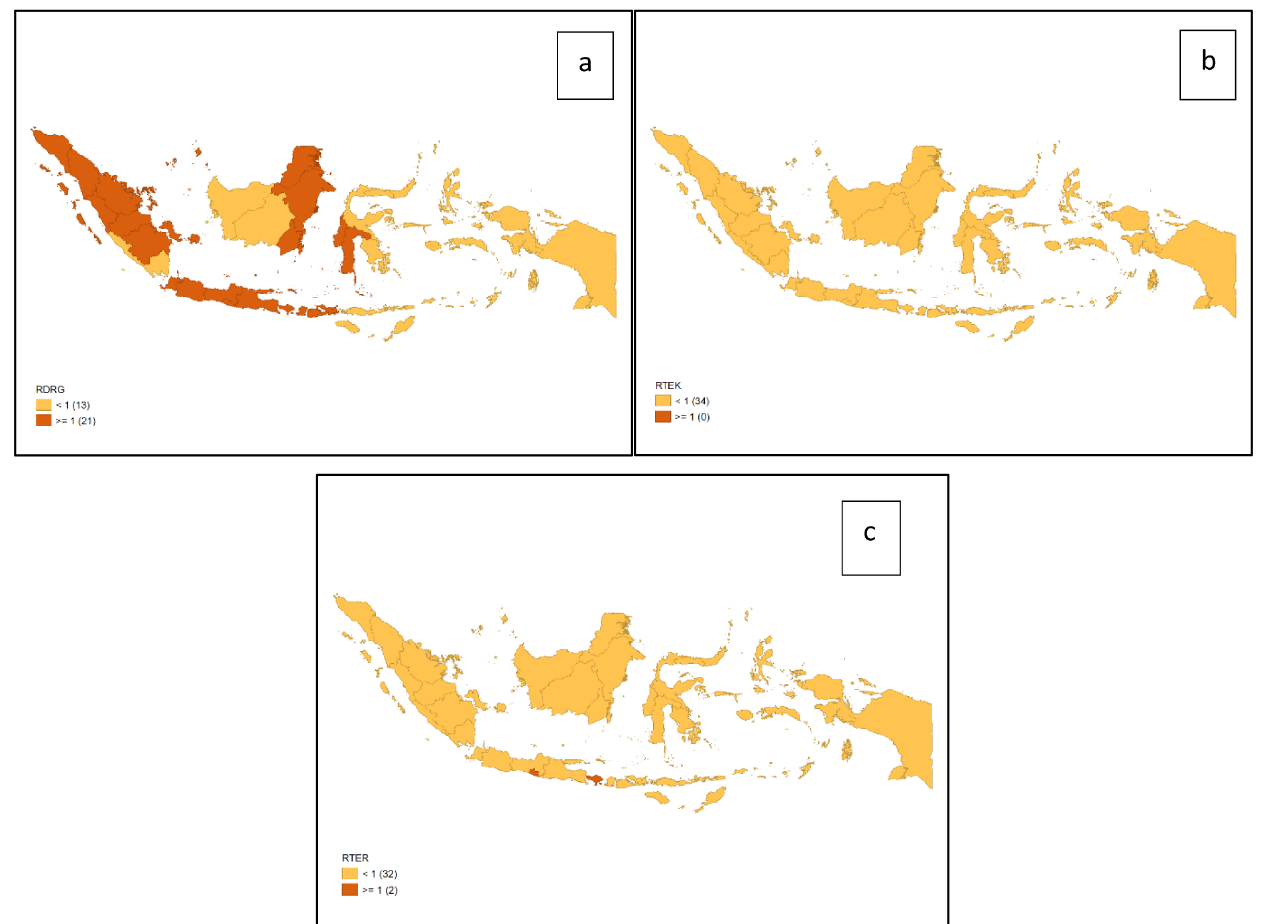
Figure 5. Visualization maps of dentists per area ( a ), dental therapists per area ( b ), and dental technicians per area ( c ). Orange = <1; red = ≥